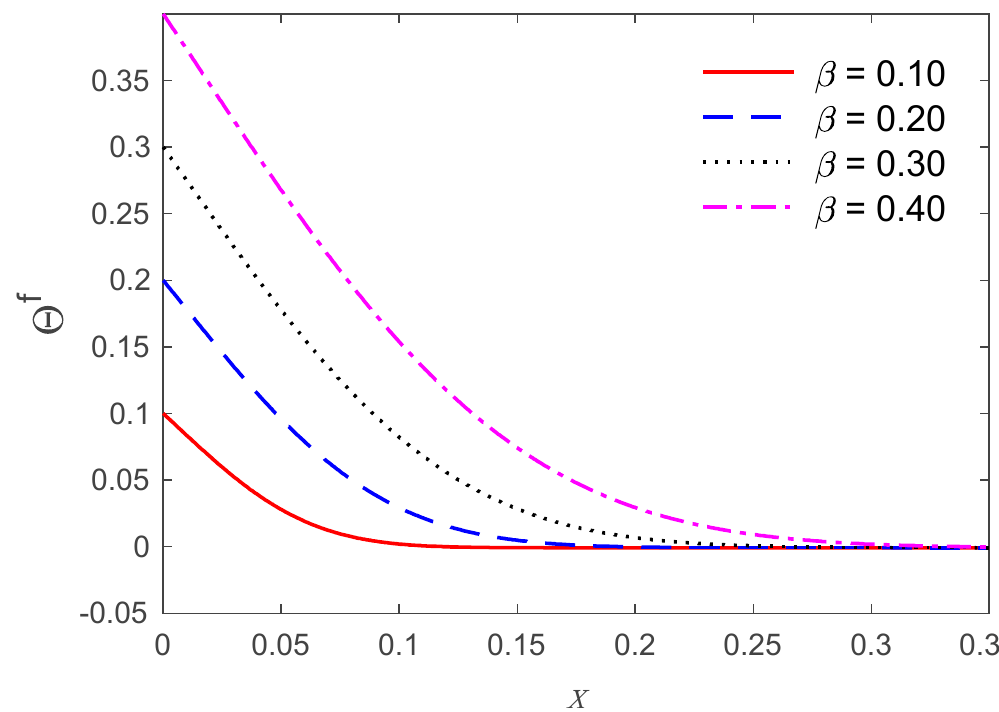
Figure 7. The effects of porosity on the fluid temperature variations.